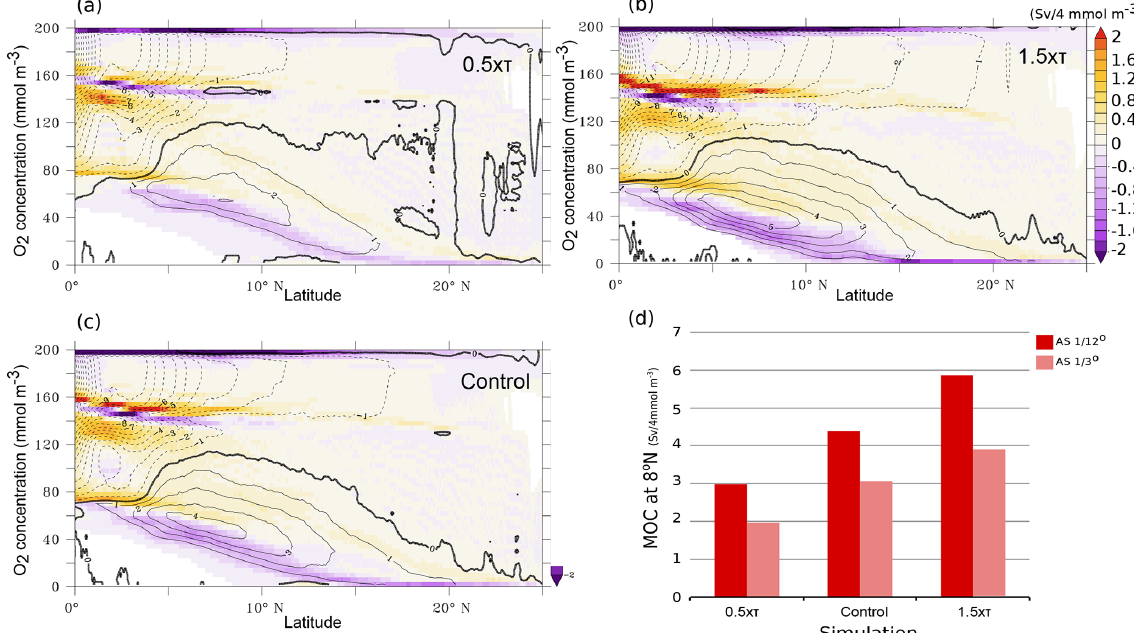
Figure A10. Meridional transport in O 2 classes as a function of wind and resolution. Meridional overturning circulation (MOC) in O 2 coordinate as a function of latitude (a–c) under different wind scenarios. Contour lines indicate the meridional stream function (positive indicates clockwise circulation). The color shading shows the meridional component of the transport (in Sv/4mmolO 2 m − 3 ). (d) Simulated MOC at 8 ◦ N under different wind scenarios using two model resolutions. We compute the meridional overturning circulation in oxygen coordinates following Lachkar et al. (2016). This approach allows us to characterize the ventilation of the OMZ driven by both the mean meridional circulation and eddy mixing along isopycnals. In practice, this consists in binning the meridional transport by O 2 classes for each model resolution. The details of the method and its mathematical formulation are provided in Lachkar et al. (2016). Waters with intermediate oxygen concentrations that are above the hypoxic threshold enter the Arabian Sea at 8 ◦ N (latitude of the southern tip of India). This is balanced by a southward export of (i) highly oxygenated surface water (O 2 > 160mmolm − 3 ) and (ii) hypoxic water (O 2 < 60mmolm − 3 ) out of the Arabian Sea. The ventilation of the OMZ can be quantified in terms of the volume of hypoxic water exported out of the Arabian